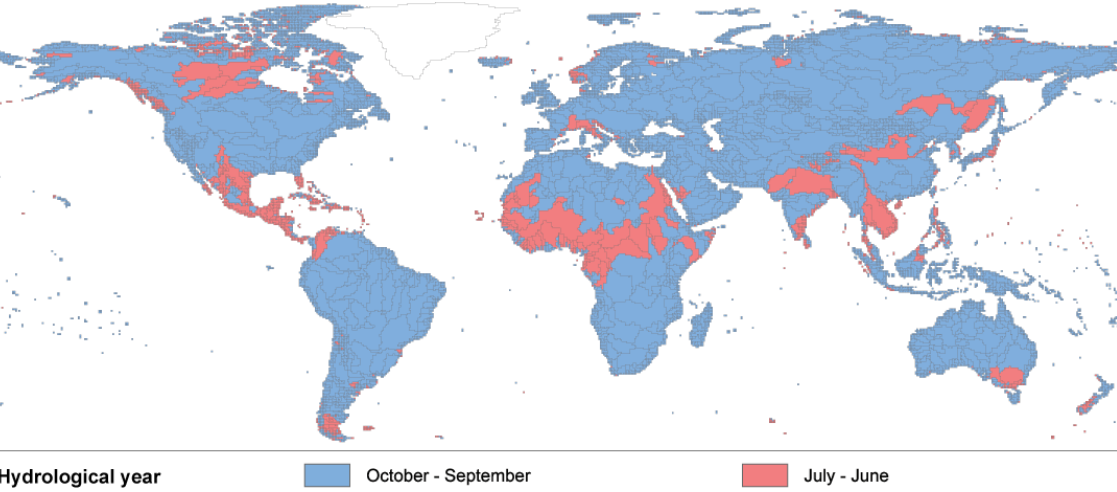
Fig. A1. Hydrological years used in this study for each basin. The standard hydrological year (October–September) was used as the default, except for in those basins in which the mean Q max of the most downstream cell occurs in the months of September, October, or November. In the latter case, the hydrological year was set to July–June.